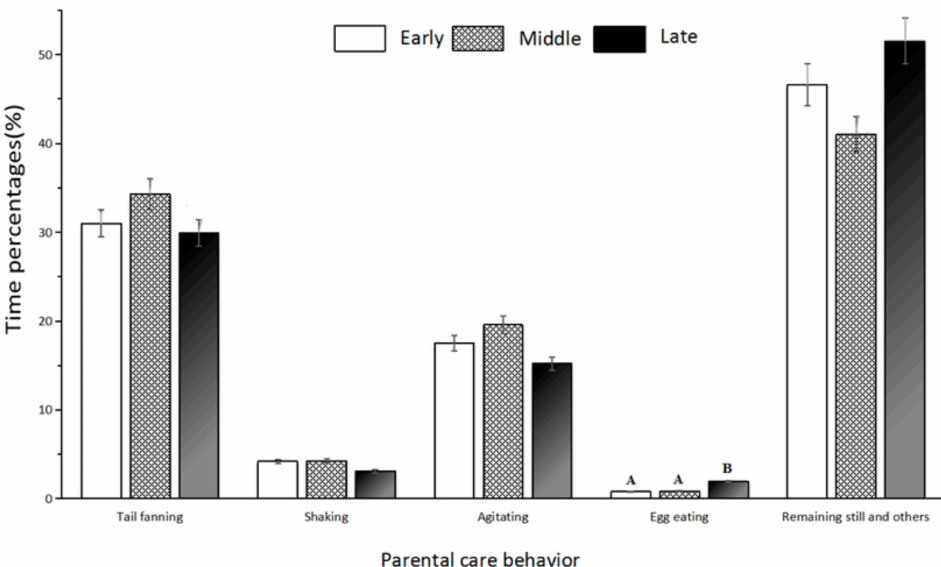
Figure 7. Time percentages of parental care behavior in A. davidianus. Note: The different codes after the average number in the same column indicate that there are differences among groups. The capital letters represent p <